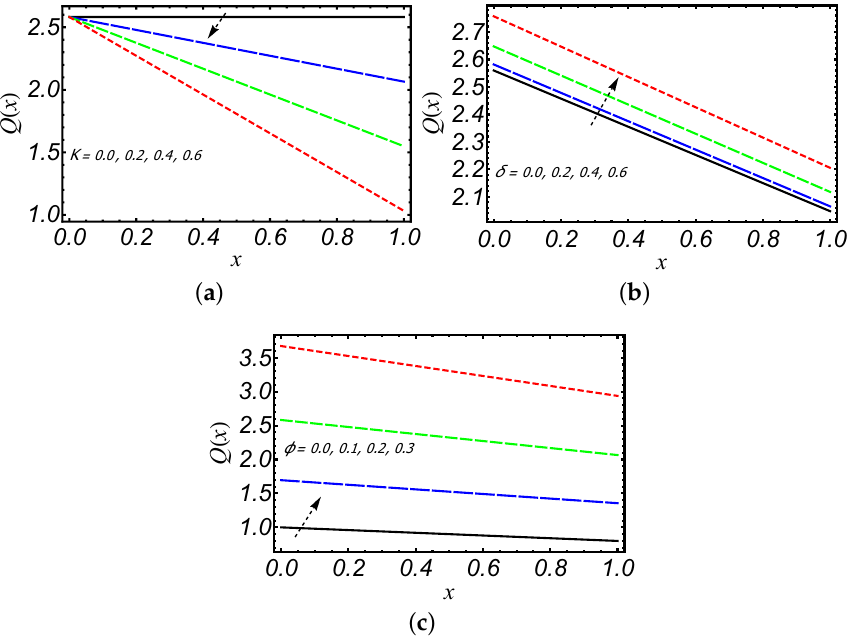
Figure 13. Behavior of Q ( x ) due to ( a ) K when φ = δ = 0.2, ( b ) δ when K = δ = 0.2, ( c ) φ when K = δ =